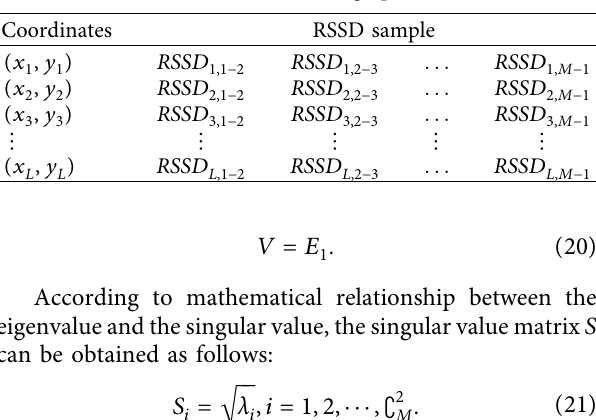
Table 3: Te ofine RSSD fngerprint